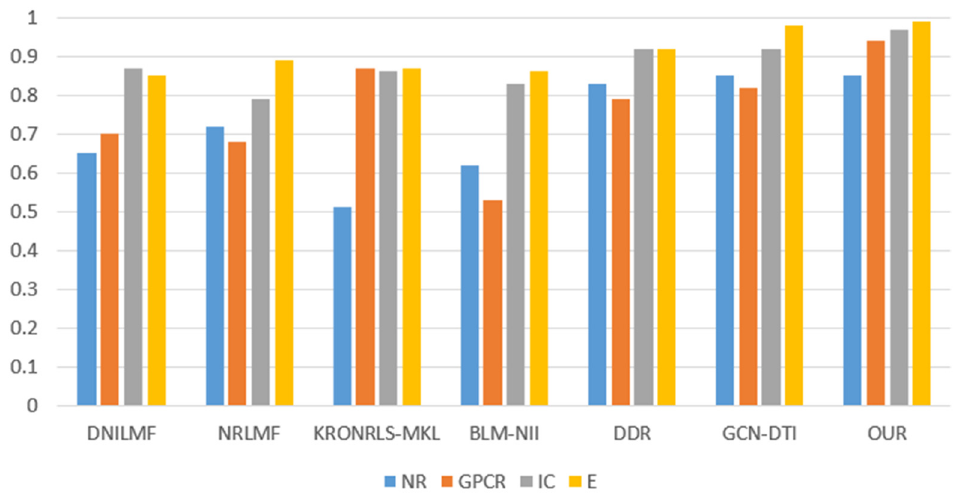
Figure 8. CVP partitioning of experimental results.